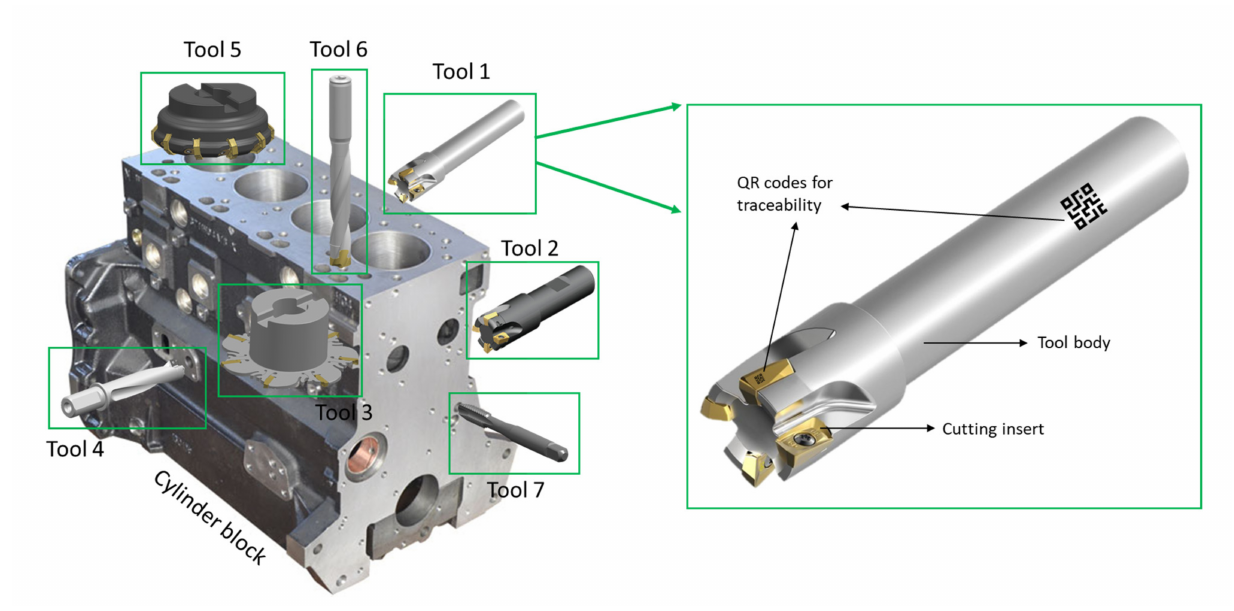
Figure 6. Application scenario showing various tools used in machining automotive cylinder